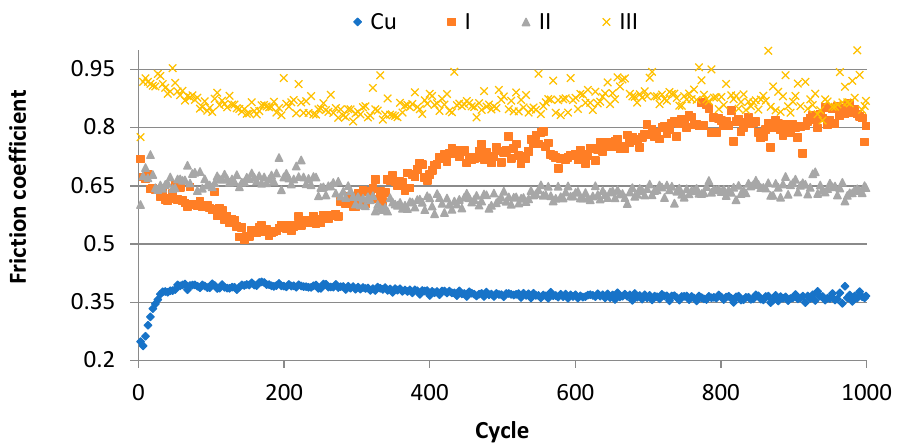
Figure 21. Comparison of the friction coefficient of the modified Cu-ETP copper surface; Cu-Cu-ETP substrate; I-CrAl coating v = 0.2 mm 3 /min; II-CrAl coating v = 0.4 mm 3 /min; III-CrAl coating v = 0.8 mm 3 /min.